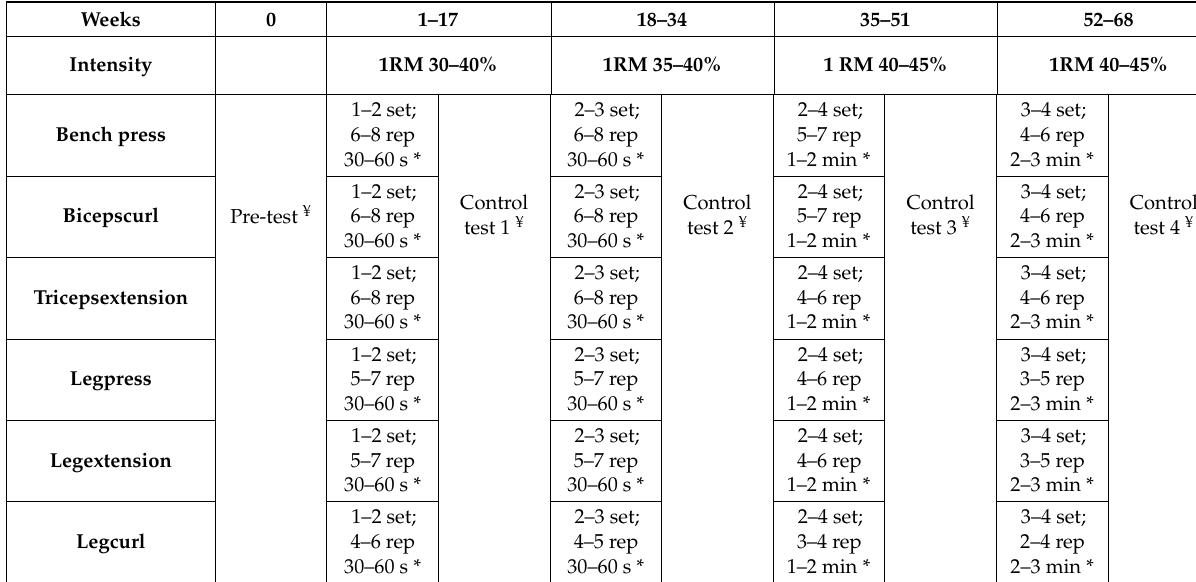
Table 2. Timetable of the resistance training